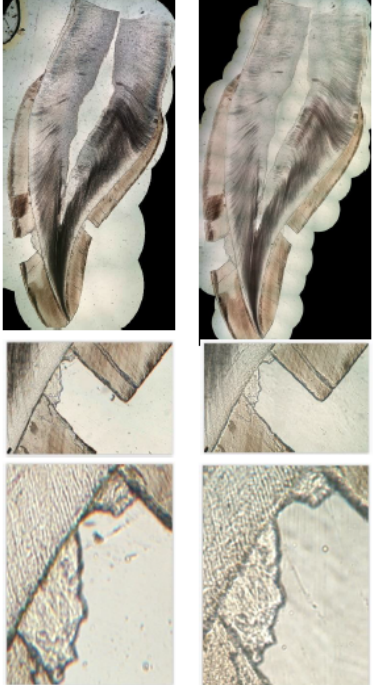
Figure 9. Same slide with × 40 magnification (left) and × 100 magnification (right), showing no significant improvement